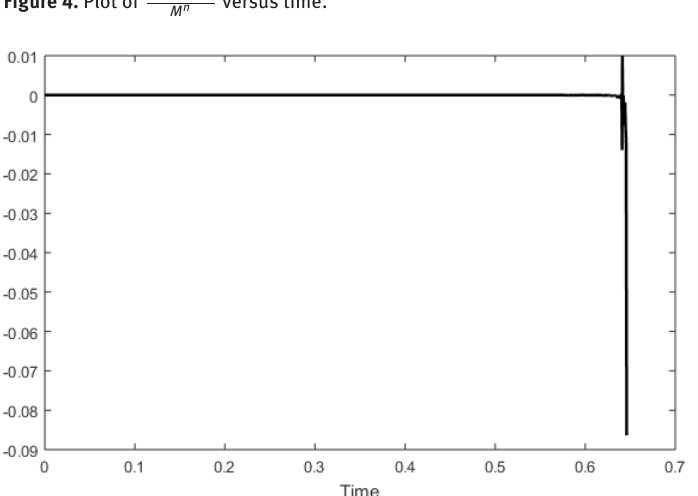
Figure 4. Plot of M n + 1 − M n